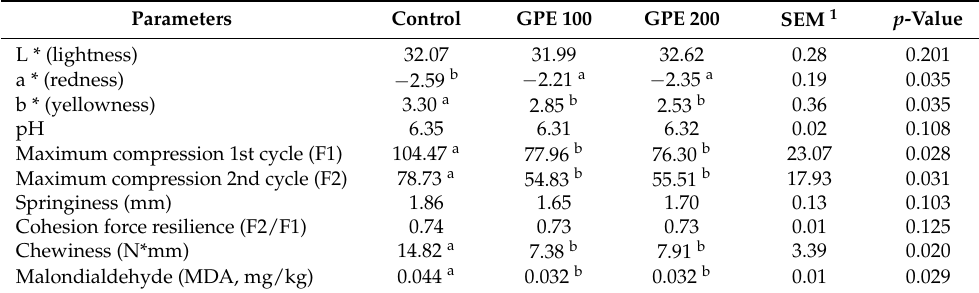
Malondialdehyde (MDA, mg/kg) 0.044 a GPE 100: red grape polyphenol extract 100 mg/kg; GPE 200: red grape polyphenol extract 200 mg/kg. 1